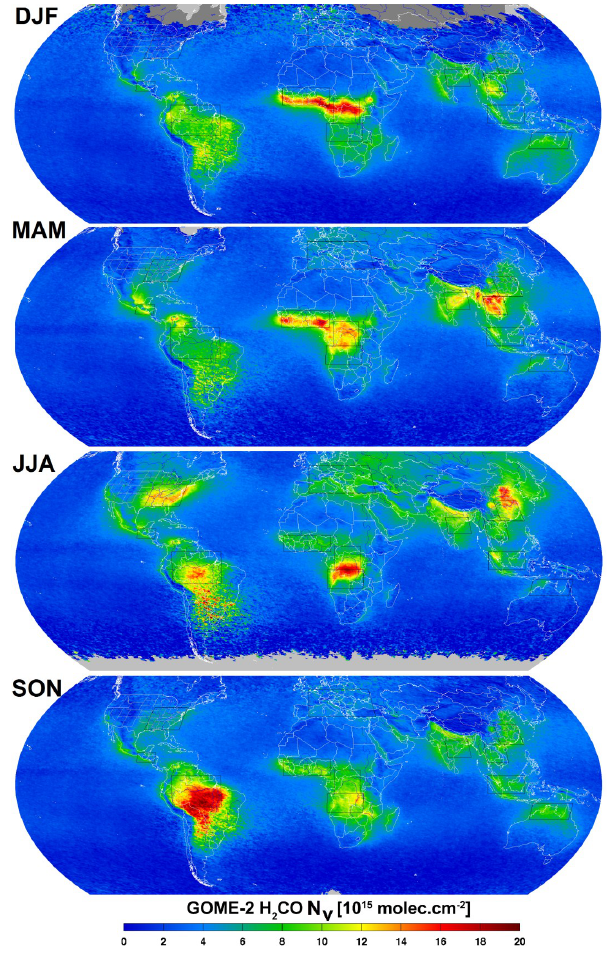
Figure 9: GOME-2 (v12) seasonal H 2 CO vertical columns averaged between 2007 and 2011. Fig. 9. GOME-2 (v12) seasonal H 2 CO vertical columns averaged between 2007 and